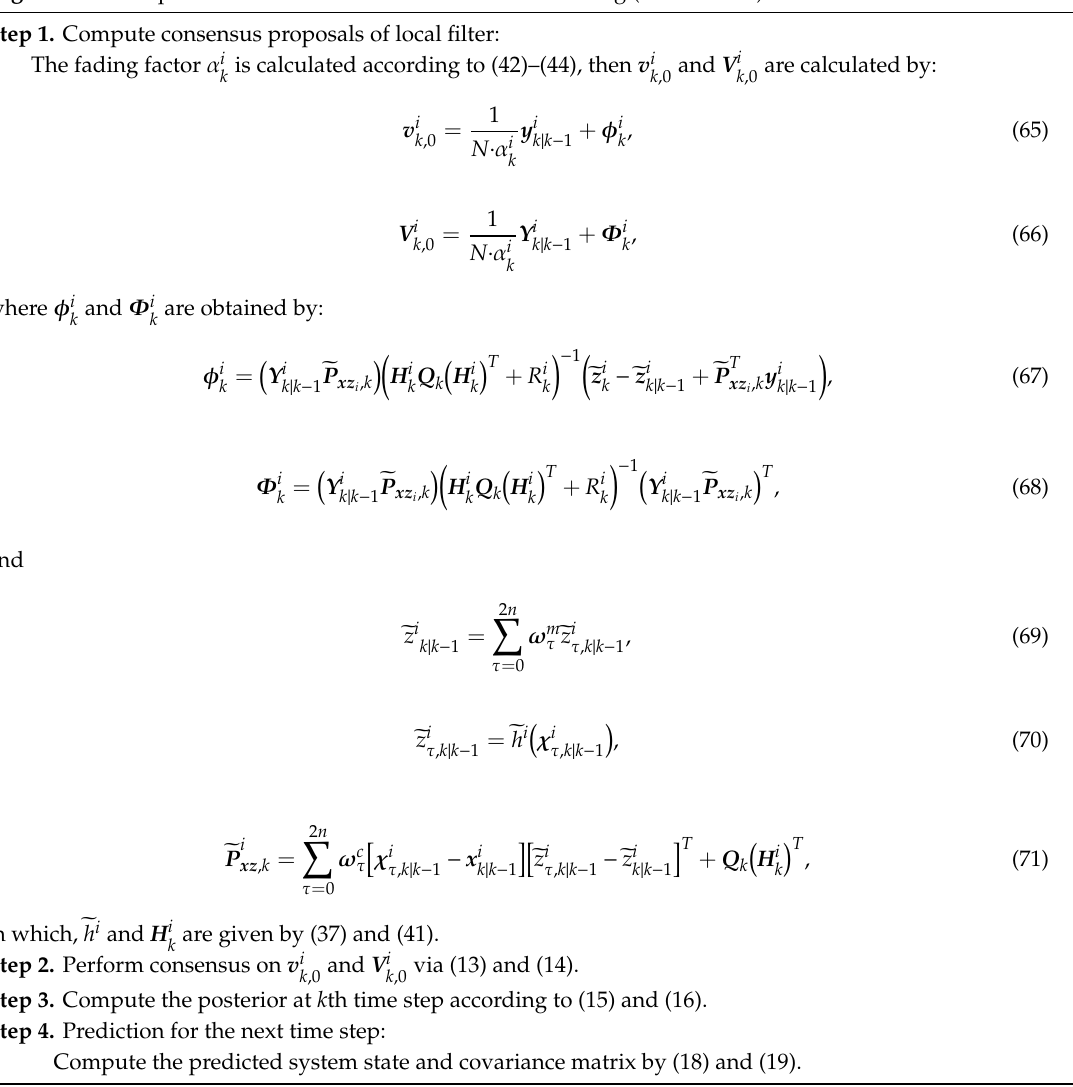
Algorithm 3 Adaptive CUIF based on measurement di ff erencing